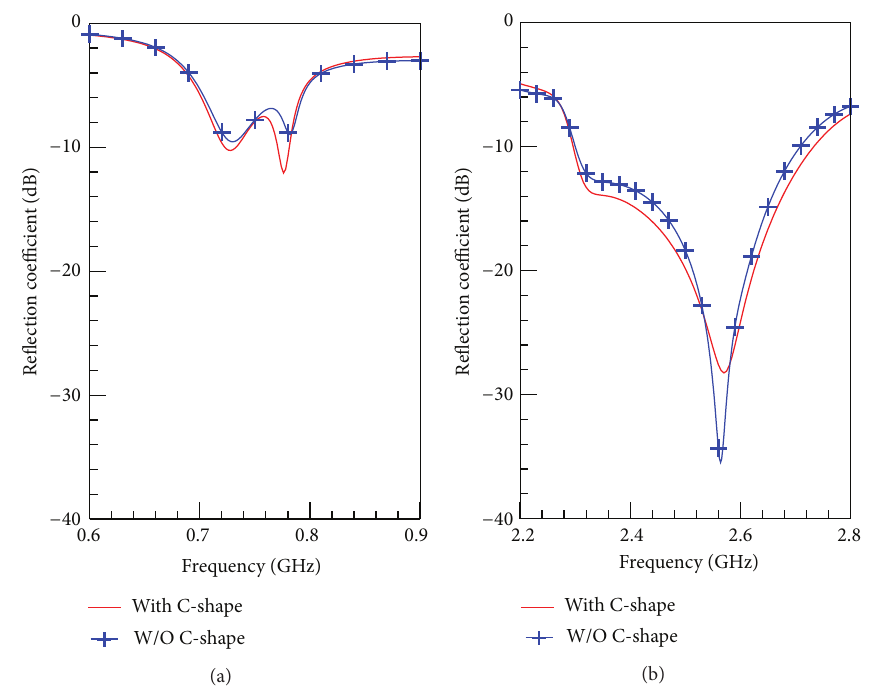
Figure 5: Simulated reflection coefficient of the proposed antenna with and without the C-shape coupler.